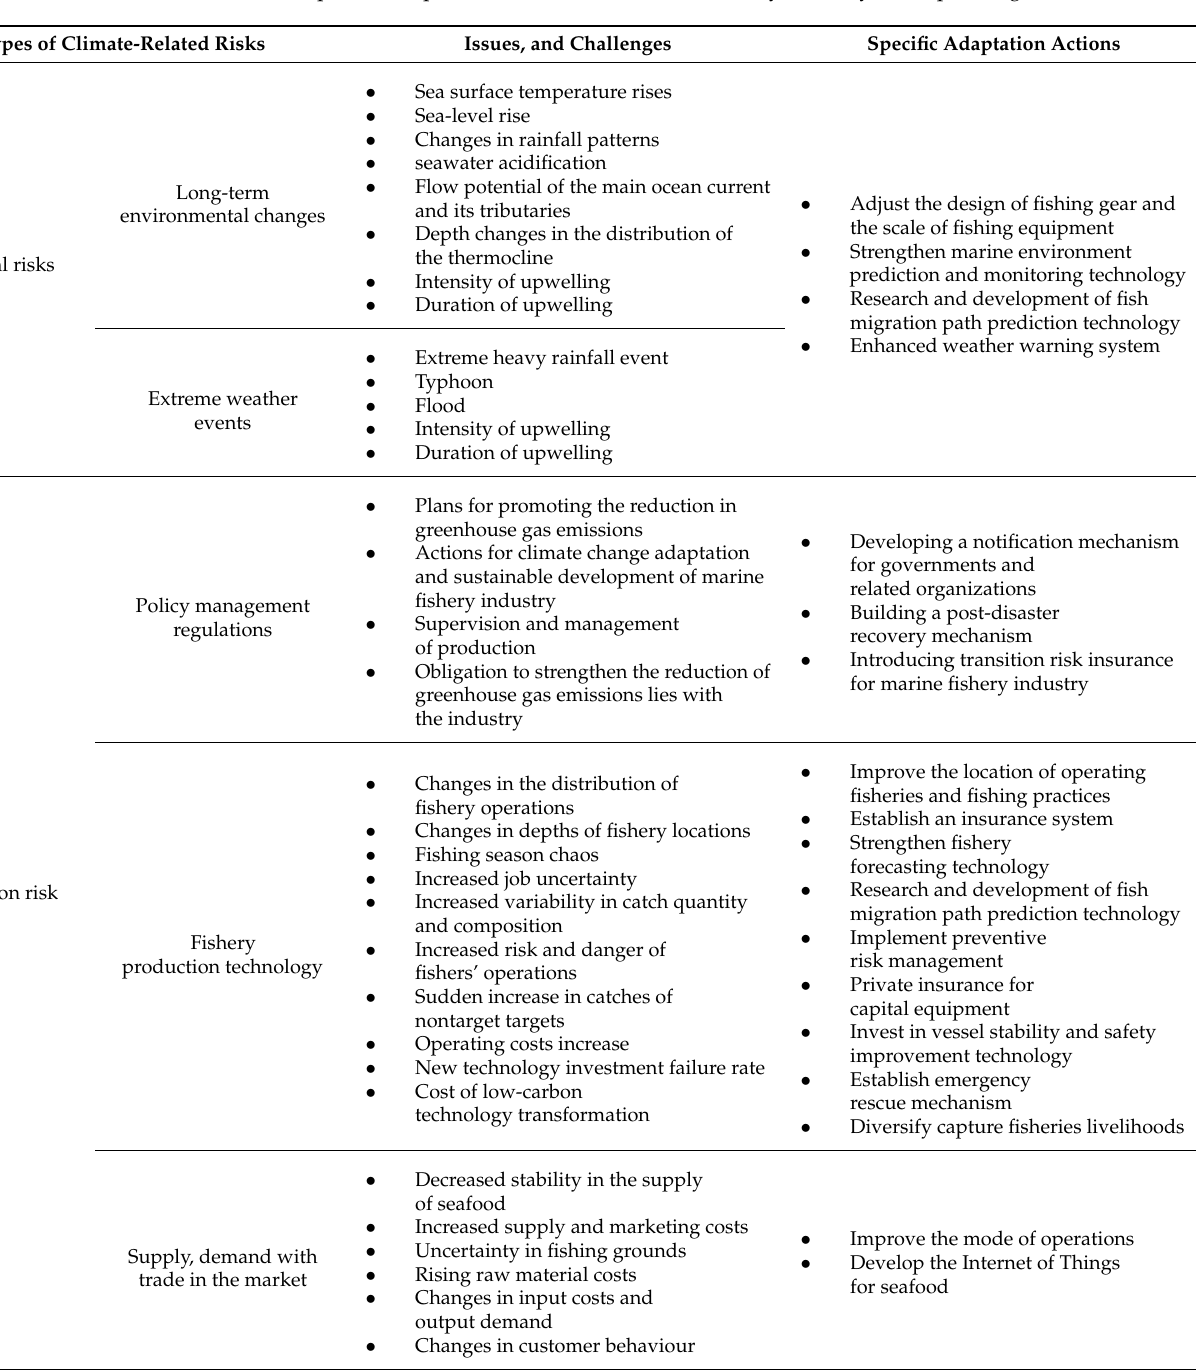
Table 4. Specific adaptation actions in the marine fishery industry corresponding to climate